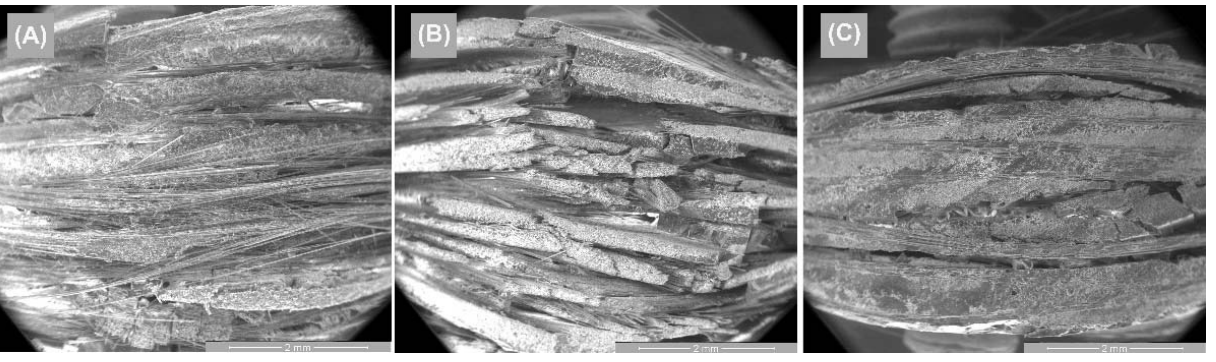
Figure 14. Surface SEM images of transversal 0–90 GFRP sample: ( A ) 100×, ( B ) 200×, ( C ) 500×, and ( D ) 2000×.